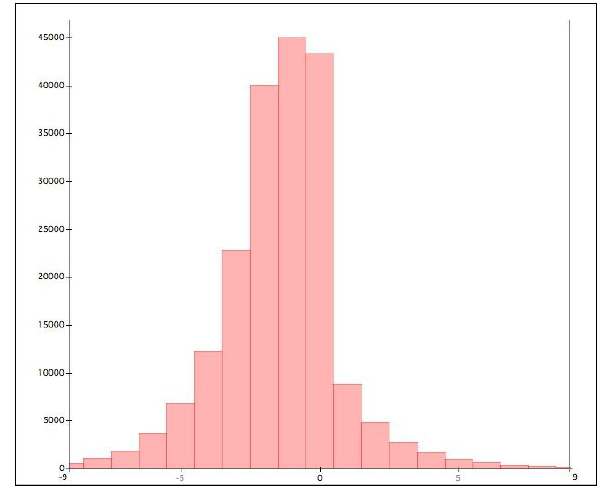
Figure 4 – HRS and TerraSAR-X Elevation